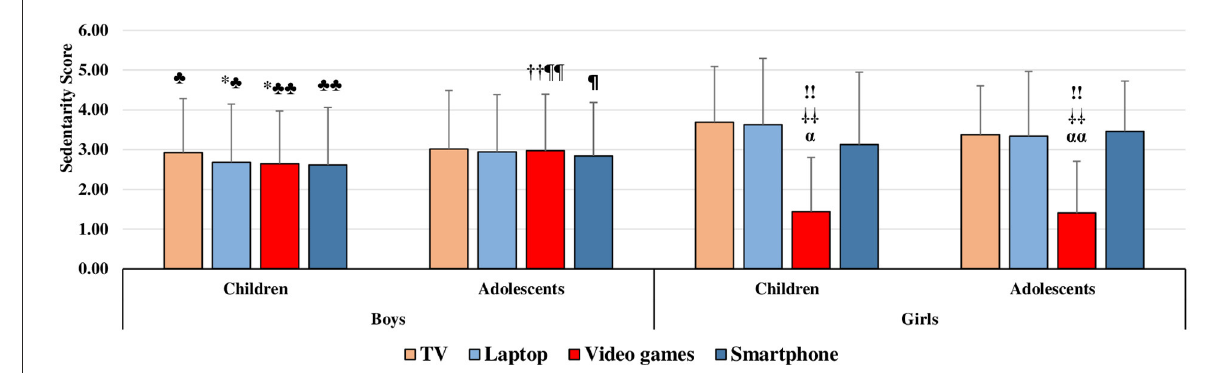
FIGURE4 Sedentary behaviors self-report for Saudi students stratified by sex and age category. * significant difference in prepubescent boys vs. prepubescent girls; ♣ significant difference in prepubescent boys vs. adolescent girls; † significant difference in adolescent boys vs. prepubescent girls; ¶ significant difference in adolescent boys vs. adolescent girls. ! differs to laptop use; α differs to smartphone use; differs to playing video games. Physical activity questionnaire for older children PAQ-C (Kowalski et al., 2004), scored on a 5-point scale; 1 corresponds to lowest PA, and 5 corresponds to highest PA. The values of PA are presented as means ( ± SD).